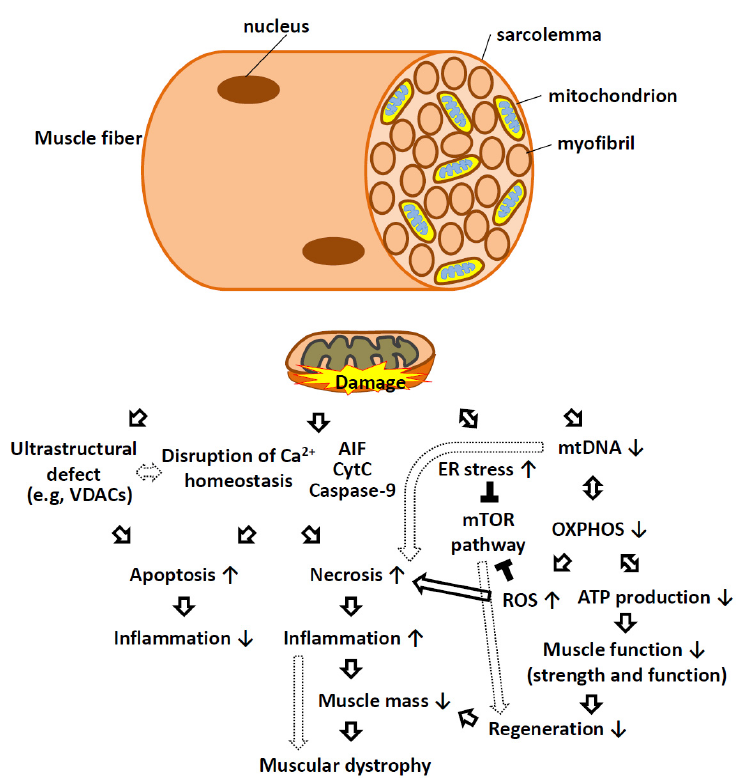
Figure 3. Schematic representation of mitochondrial dysfunction as causative factors in muscular dystrophy. In skeletal muscle fibers, mitochondria are located between myofibrils, surrounding